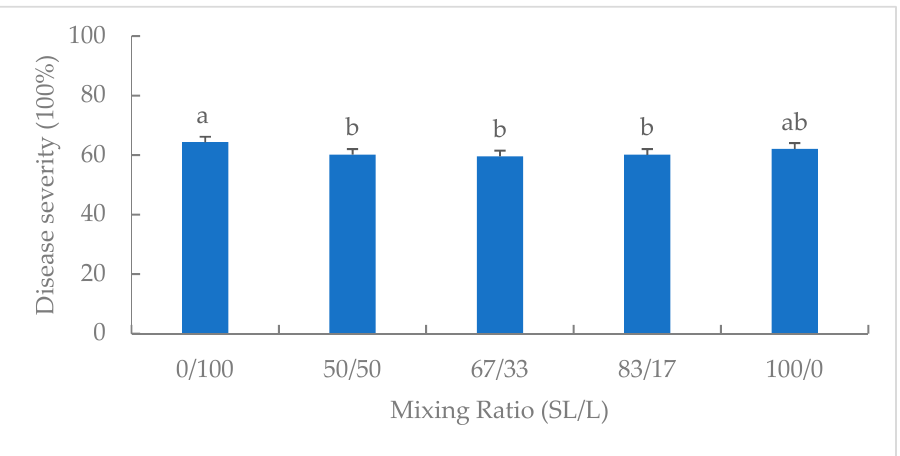
Figure 3. Effect of leaf-type mixing ratio on disease severity. The ratios were listed as semi-leafless + leafed peas. Mean of one site in 2017, two sites in 2018, and two sites in 2019. Columns with different letters (a, b) represent that the mean of disease severity were significantly different in LSD 0.05 . The error bar represents the positive standard error in LSD 0.05 .